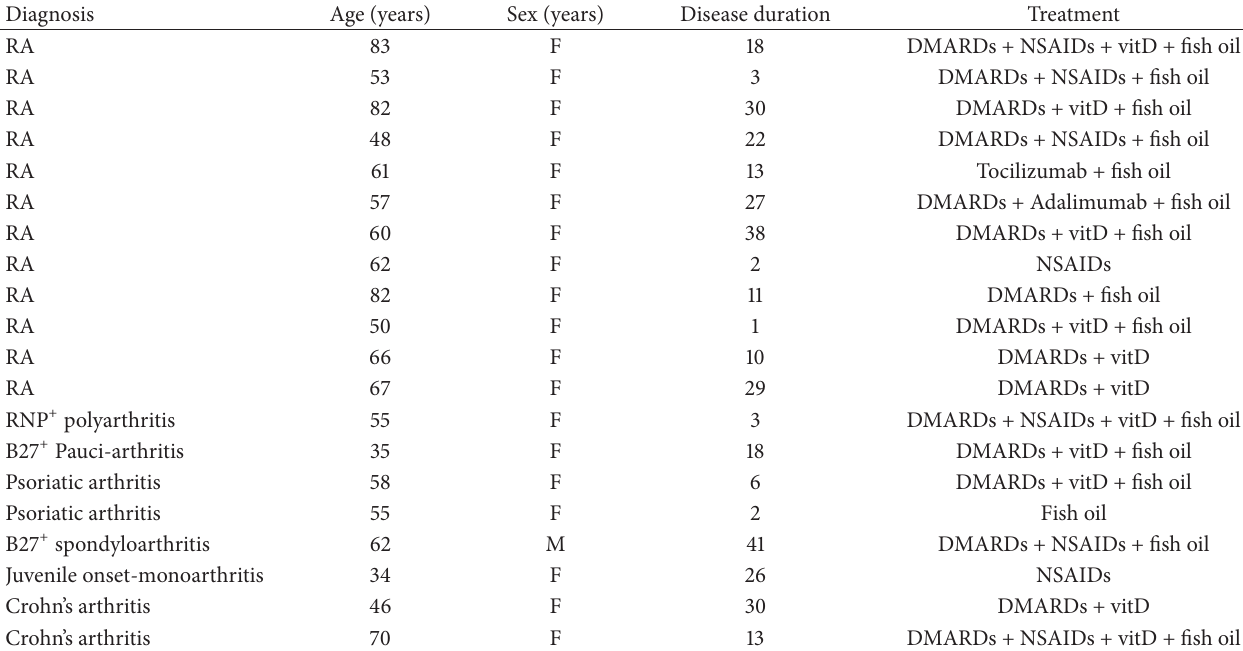
Table 1: Demographic and clinical characteristics of patients.